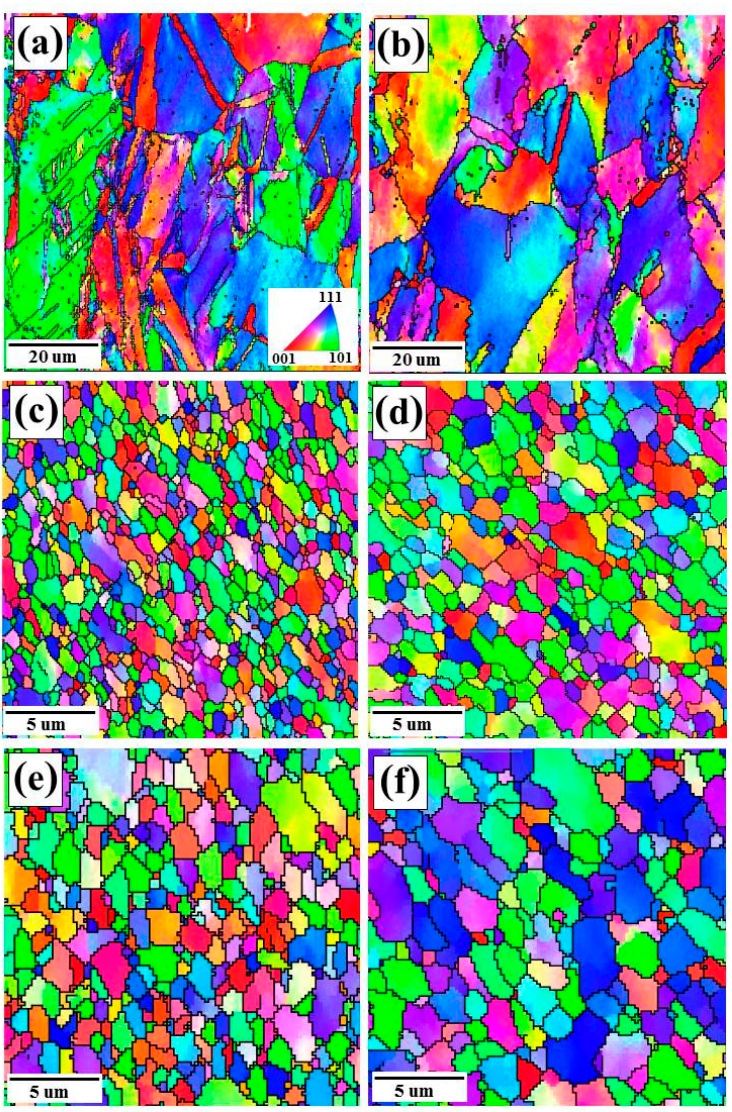
Figure 5. Inverse pole figure maps in the different regions. ( a ) CuNiCrSi-BM; ( b ) CuCrZr-BM; ( c ) CuNiCrSi-NZ under condition A5; ( d ) CuCrZr-NZ under condition A5; ( e ) CuNiCrSi-NZ under condition A7; ( f ) CuCrZr-NZ under condition A7.